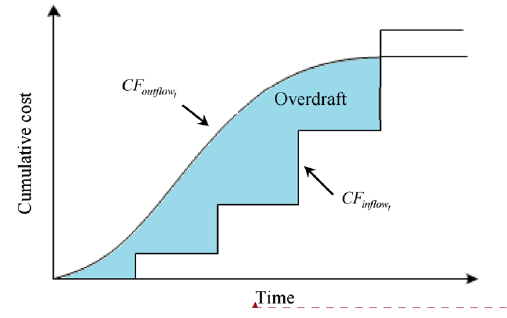
Fig. 5. Project overdraft requirement